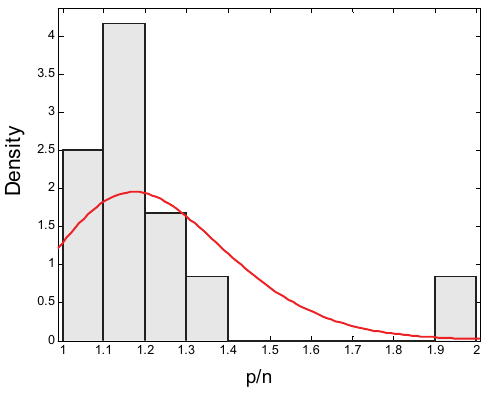
Fig. 3. Distribution of p/n values from the staging of pups and the fitted lognormal probability density function to the observed